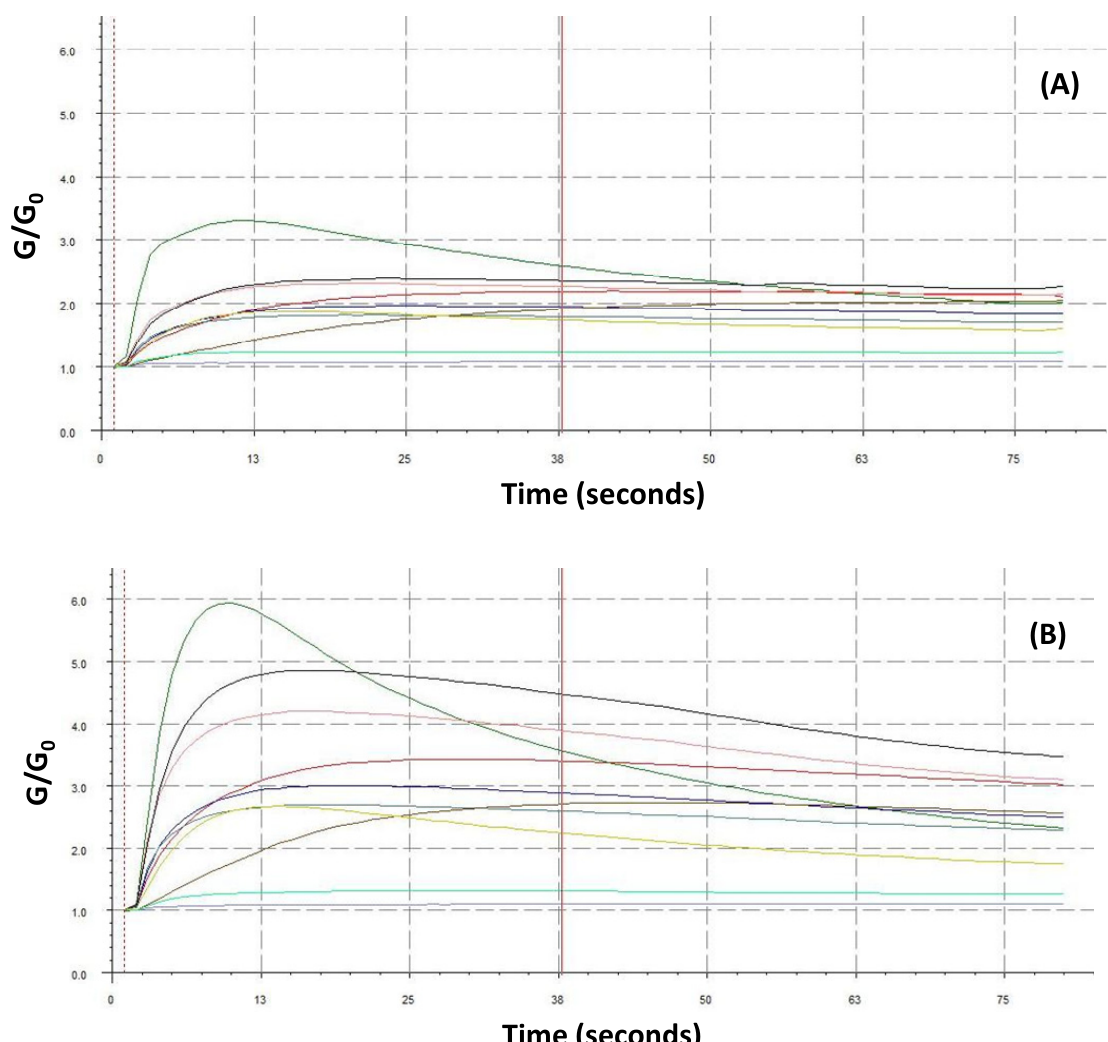
Figure 5. Typical sensor-response outputs from representative samples of healthy wood blocks (controls), and inoculated wood blocks (decayed). Sensory array output from: (A) a non-inoculated sample of Acer saccharinum , (B) and a decayed wood sample of A. saccharinum after inoculation with Armillaria mellea . Histograms of normalized intensity responses of individual sensors to headspace volatiles produced by the same Q. lyrata - samples for non-inoculated (C), and decayed wood (D), respectively. G/G the conductivity response of the sensors to the sample gas (G) relative to the carrier gas ) over time. The following data were adjusted relative to the carrier gas (G 0